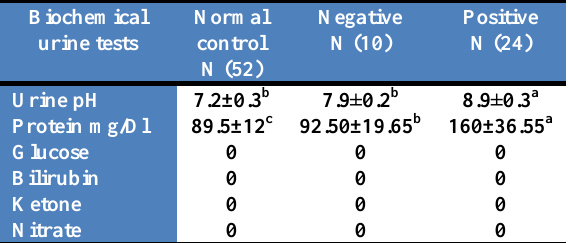
Table, 2: Biochemical urine tests of normal control, negative and positive bacterial urine culture samples of slaughtered buffaloes (Mean